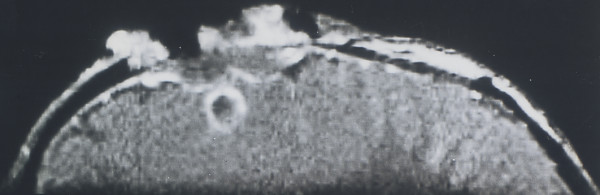
Nuclear magnetic resonance imaging revealing tumor infiltration of the cranium and frontal cortex.